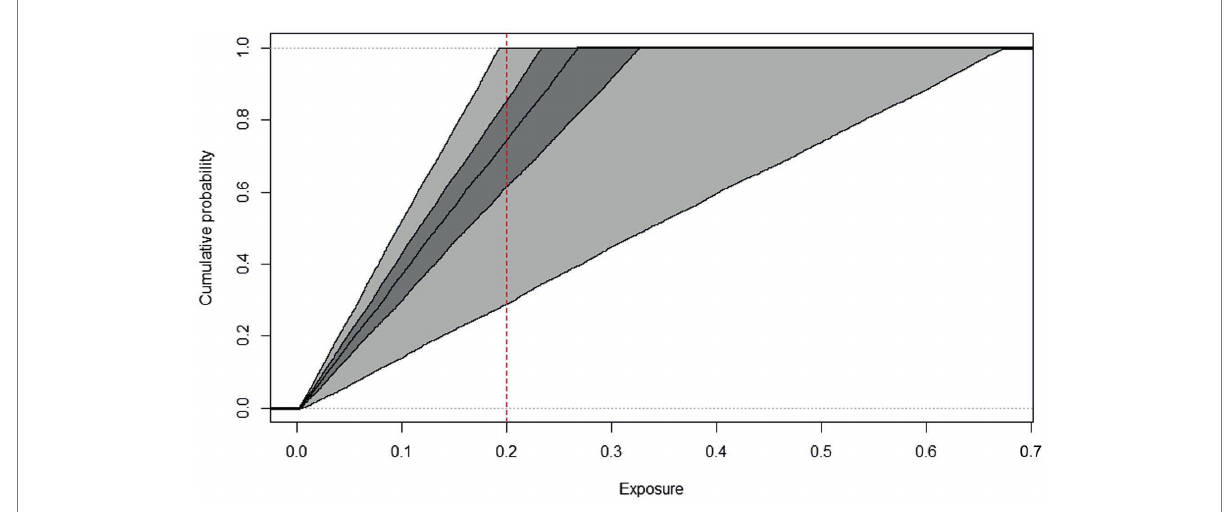
FIGURE 5 Cumulative frequency distributions of AFM1 exposure of toddlers, indicating the threshold used for HI calculation (dashed line), years